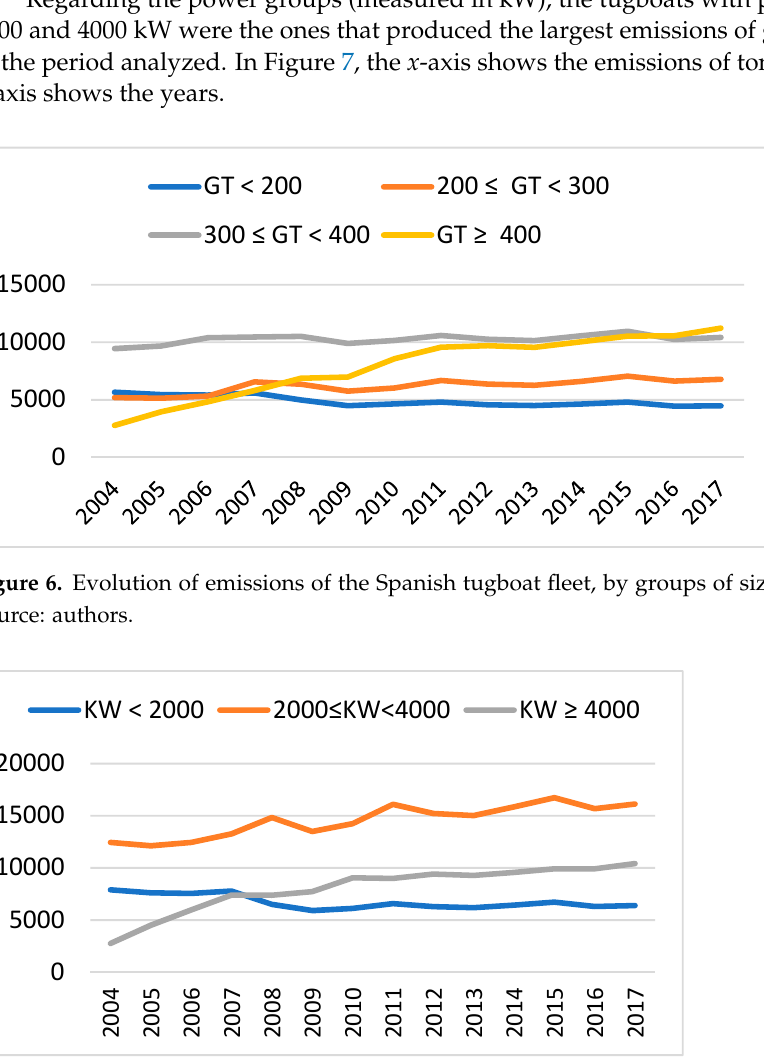
Figure 7. Evolution of emissions of Spanish tugboat fleet, by groups of power, measured in kW.